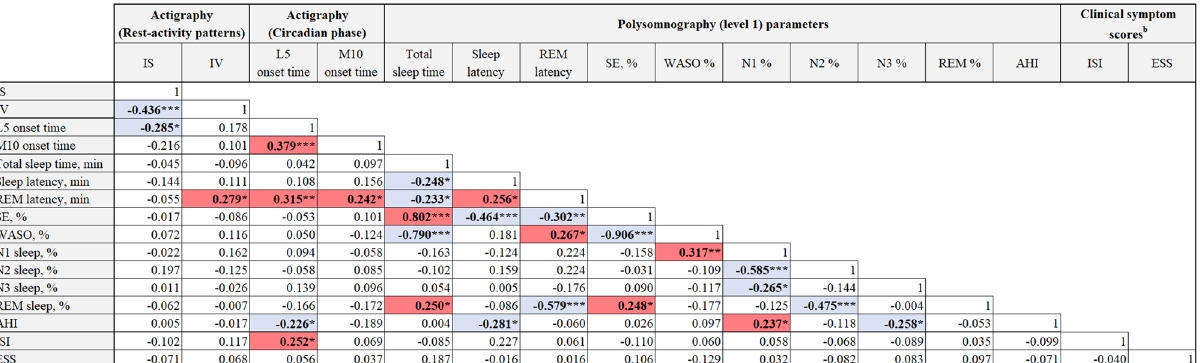
Table 2. Exploratory correlation analyses among rest-activity patterns, circadian phase, level 1 PSG parameters, and clinical symptom scores a . AHI apnea–hypopnea index, ESS Epworth sleepiness scale, IS inter-day stability, ISI insomnia severity index, IV intra-daily stability, L5 onset time least active 5-h onset time, M10 onset time most active 10-h onset time, REM rapid eye movement, WASO wakefulness after sleep onset. a Pearson correlation test was performed between two normally distributed continuous variables. Otherwise, Spearman rank correlation test was performed. Red and blue boxes indicate significant positive and negative associations, respectively. b Five participants did not complete the insomnia severity index (n = 70), and one participant did not complete the Epworth sleepiness scale (n = 74).